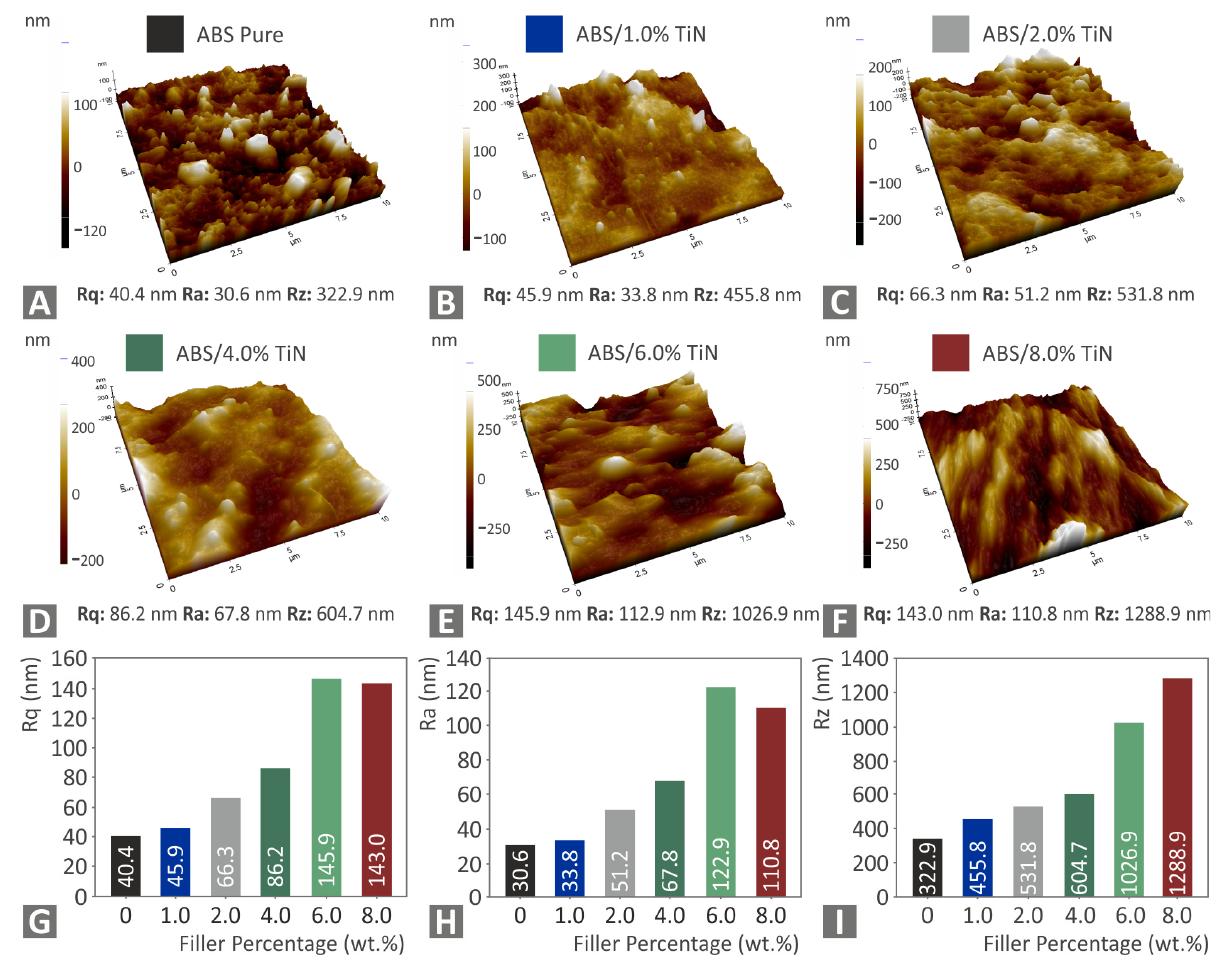
Figure 6. AFM images of the side surface of the tested filaments for ( A ) pure ABS ( B ) ABS/1 wt. % TiN ( C ) ABS/2 wt. % TiN, ( D ) ABS/3 wt. % TiN, ( E ) ABS/6 wt. % TiN, and ( F ) ABS/8 wt. % TiN, and graphs for the surface roughness parameters vs. the TiN concentration in the nano-compounds ( G ) Rq, ( H ) Ra, ( I ) Rz.